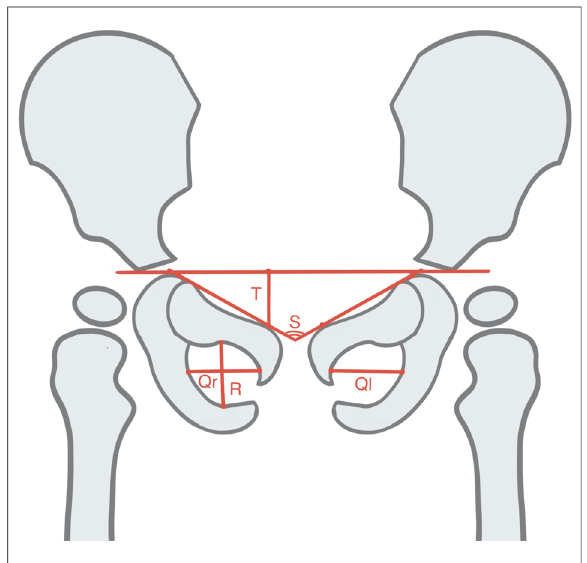
FIGURE 1 Schematic view of a standard pelvic plain fi lm. Quotient of pelvic rotation (Qr/Ql), Symphysis os-ischium angle ( S ), and Pelvic tilt index